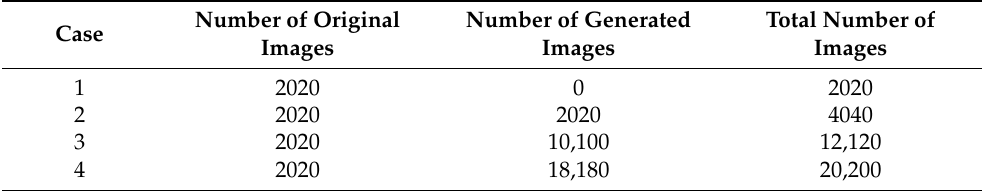
Table 4. Variations in number of original and generated images used for classifier